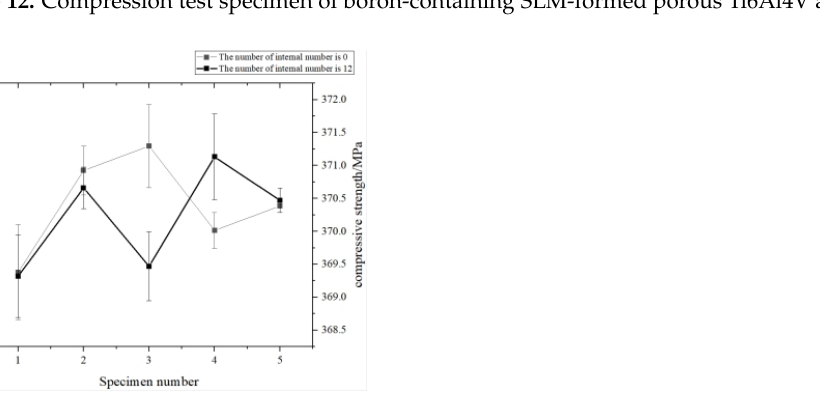
Figure 13. Error bars chart of compression parts error with the number of internal struts 0 and 12, respectively.